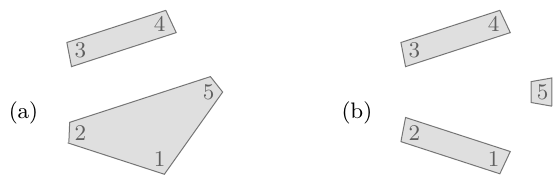
Figure 6 . Partitions of [ k ] = { 1 , . . . , 5 } : (a) Non-crossing partition P = {{ 1 , 2 , 5 } , { 3 , 4 }} . (b) Non- crossing pairing P = {{ 1 , 2 } , { 3 , 4 } , { 5 }}